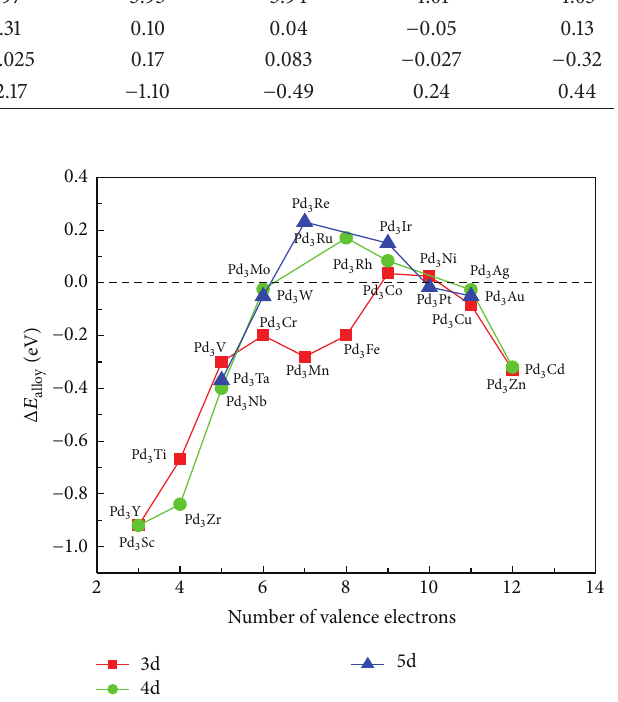
Figure 1: The relationship between the calculated formation ener- , and number of valence gies of Pd 3 M alloys, Δ𝐸 alloy